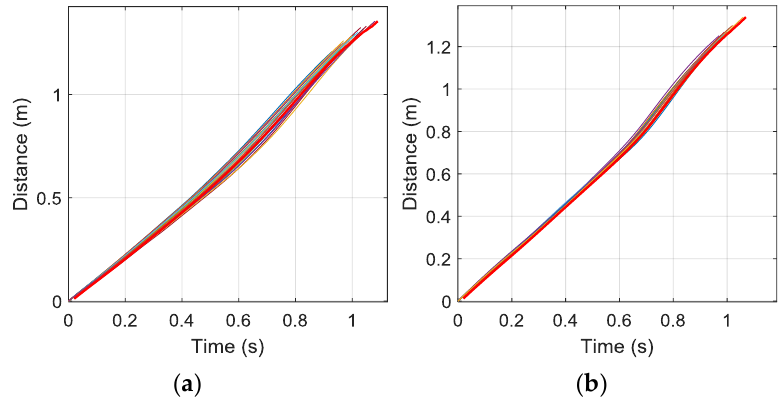
Figure 4. Individual stroke distances with the pattern overlapped (red): ( a ) left arm; ( b ) right